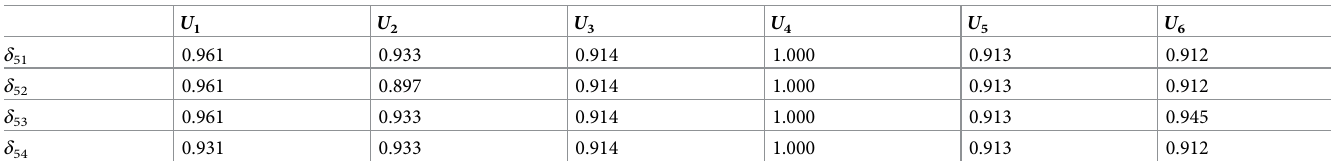
Table 18. The relative weight of O 5 to others.